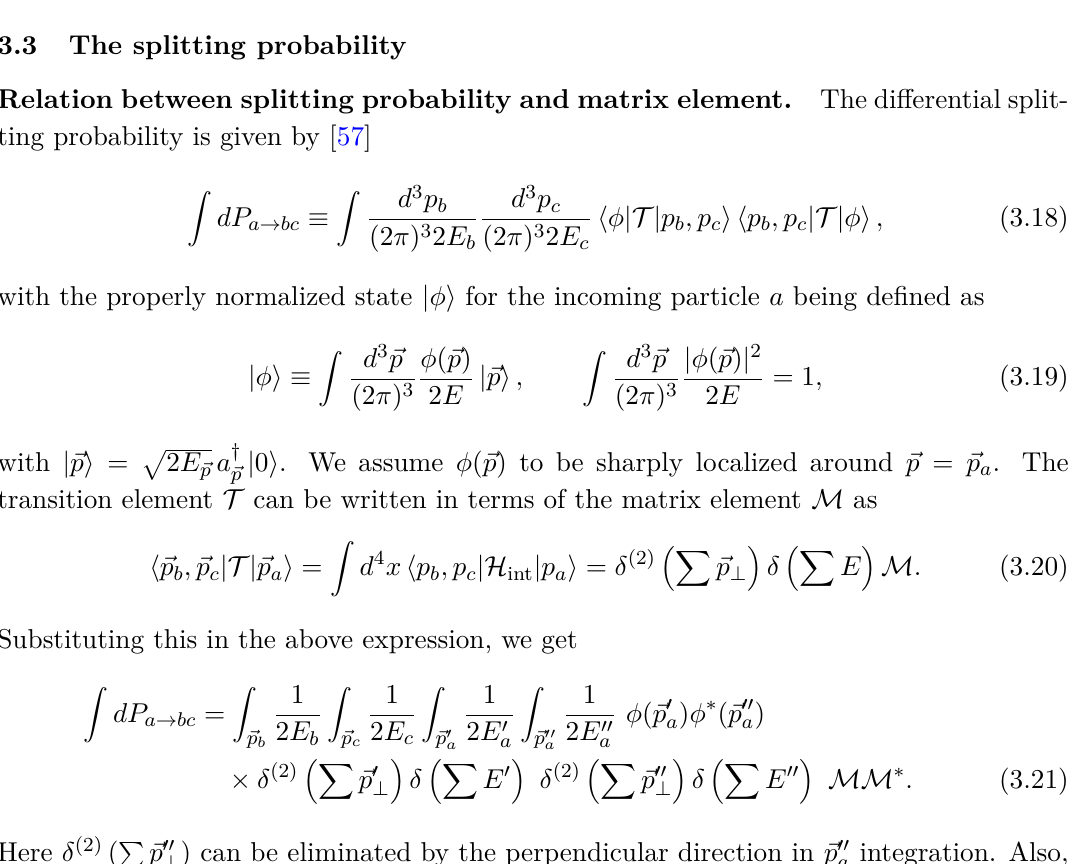
Figure 2 . Kinematically allowed region (blue) for x and k ⊥ /E a for one emitted